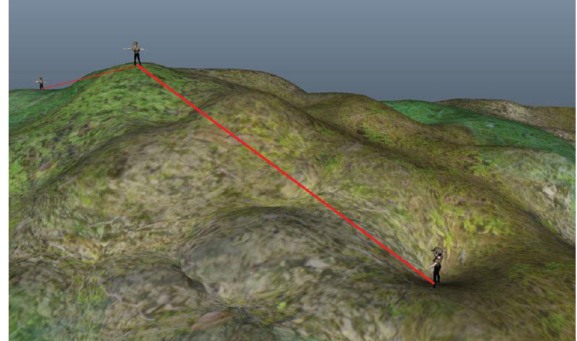
Figure 5. A rendering of the 3D model illustrating the terrain and the